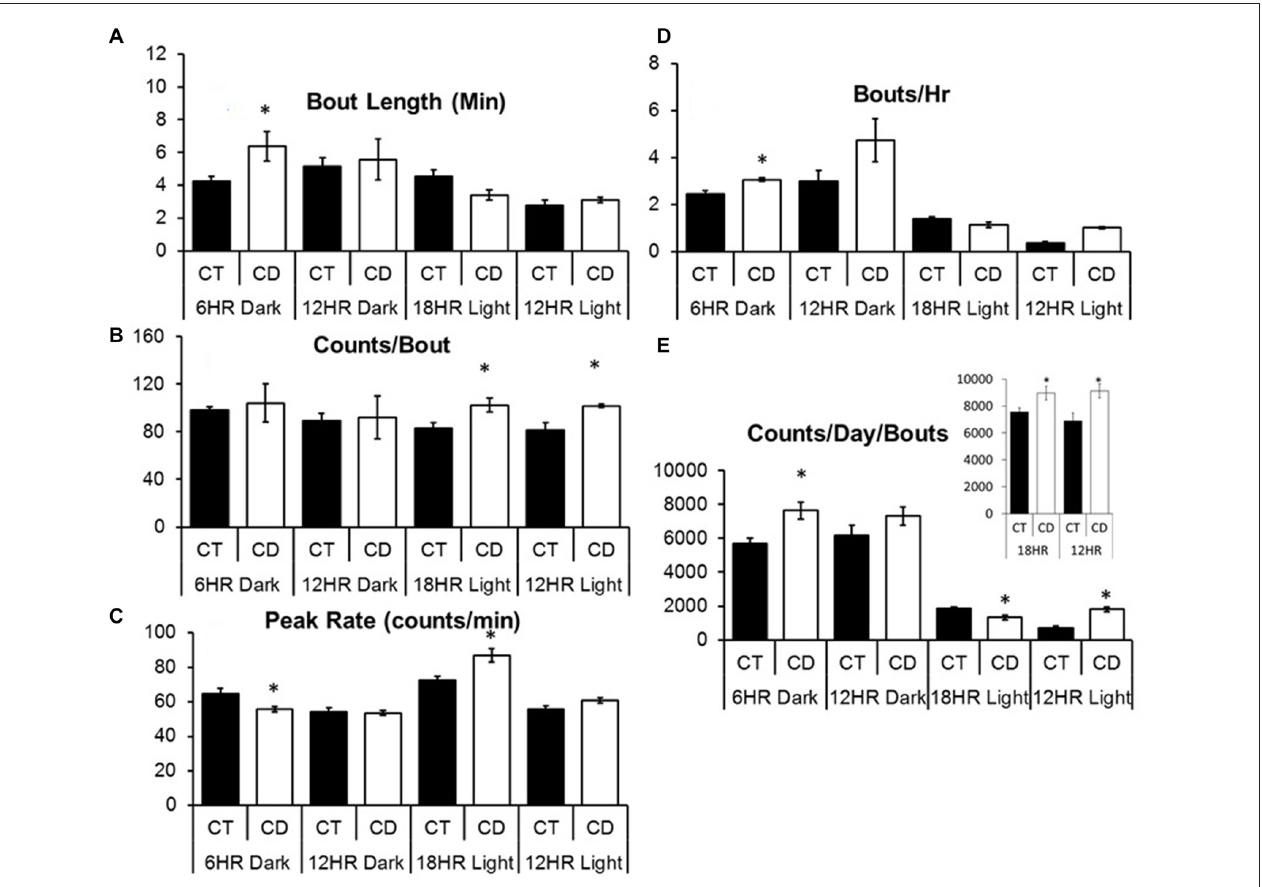
FIGURE 5 | Bout analysis of alcohol drinking by photoperiod in the 18HR environmental CD. Mice in CD had significantly longer bout lengths in the dark in the 18HR photoperiod (A) , more counts per bout in the light phase of both 12HR and 18HR photoperiods (B) , a lower peak rate in the dark, but higher peak rate in the light phase, of the 18HR photoperiod (C) , and more bouts per hour in the dark phase of the 18HR photoperiod (D) . In addition, mice in CD had more total counts per day in bouts in both experimental photoperiods as well as in the dark phase of the 18HR photoperiod and in the light phase of the 12HR photoperiod, but fewer counts per day in bouts in the light phase of the 18HR photoperiod (E) (data indicate the mean ± SEM for n = 6; asterisks indicate significant differences from baseline at p < 0.05).